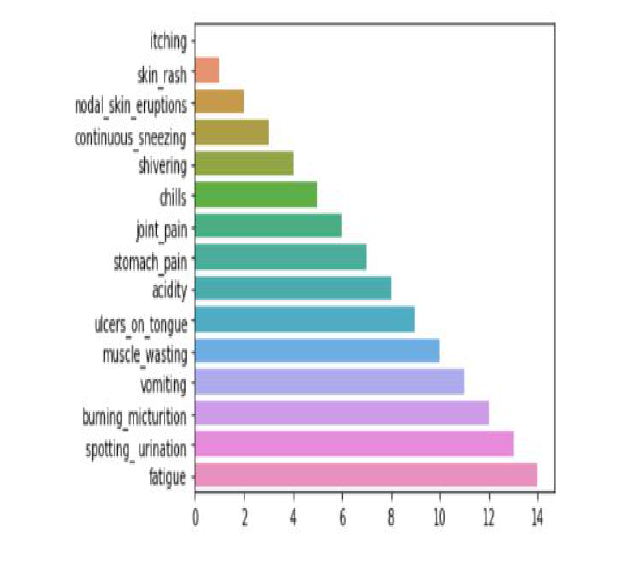
Fig. 3. Occurrence of the symptoms in the test data set The above figure demonstrates the frequency of the symptoms occuring in the data set and shows which symptom is associated with the maximum of the diseases. The data set contains various diseases and the symptoms associated with them. The model predicts the disease which matches with the symptoms in the data set with the set of symptoms entered by the user. With this methodology, we can predict the disease which is most likely associated with the set of symptoms already present in the data set.